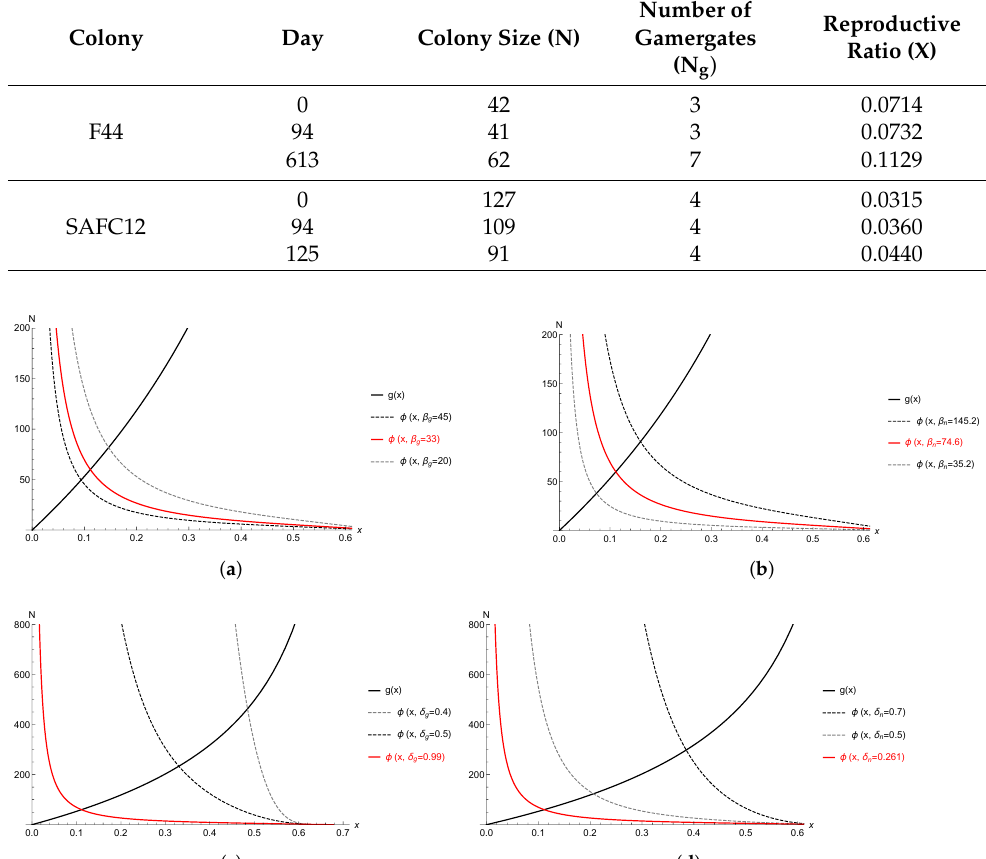
Figure 3. Plots of nullclines, i.e., φ ( x ) and g ( x ) , for different values of metabolic parameters, i.e., β n , β g , δ n , and δ g with fixed vital parameter values e = 2.42, d g = 0.00028, d w = 0.0025. ( a ) β n = 76.4, δ g = 0.99, and δ n = 0.261. ( b ) β g = 33, δ g = 0.99, and δ n = 0.261. ( c ) β n = 76.4, β g = 33, and δ n = 0.261. ( d ) β n = 76.4, β g = 33, and δ g = 0.99.